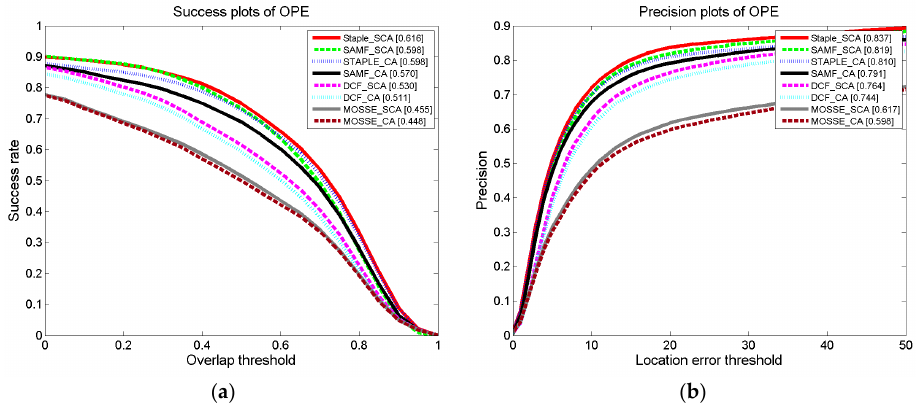
Figure 8. Success plots ( a ) and precision plots ( b ) of proposed method against the convention CA method on the 100 video sequences in Visual Tracking Benchmark [8].